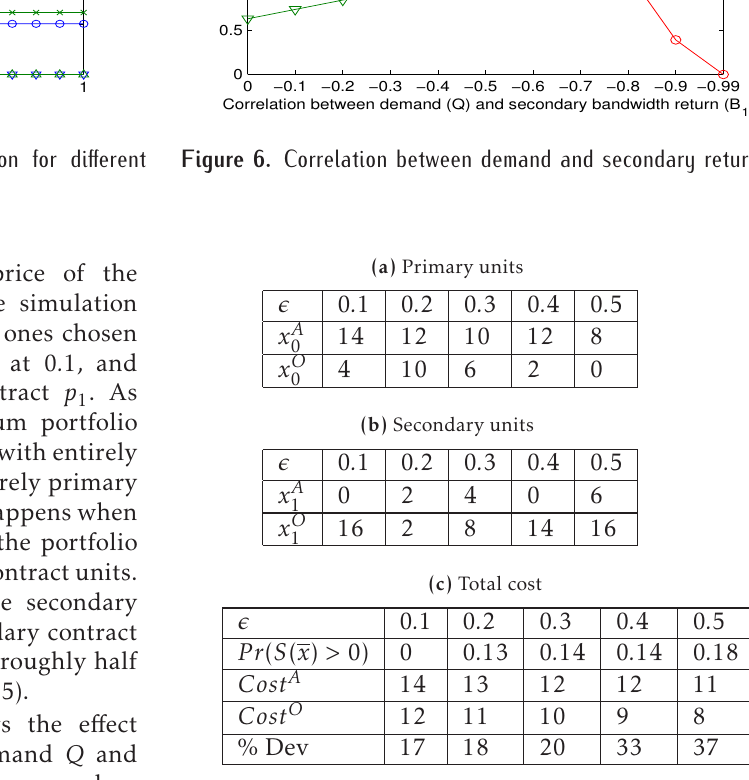
Table 1. Deviation in SPO results when Bernstein